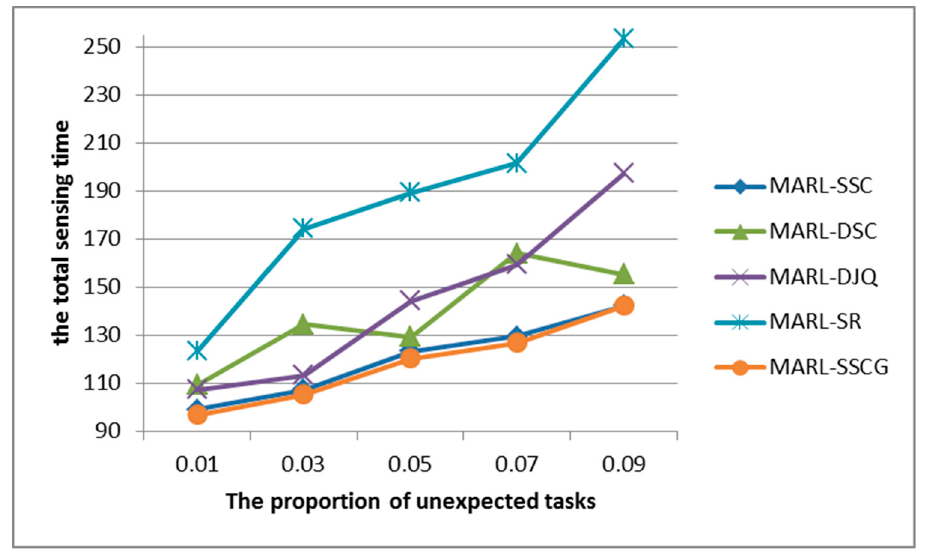
Figure 7. The total sensing time under different proportion of unexpected tasks.